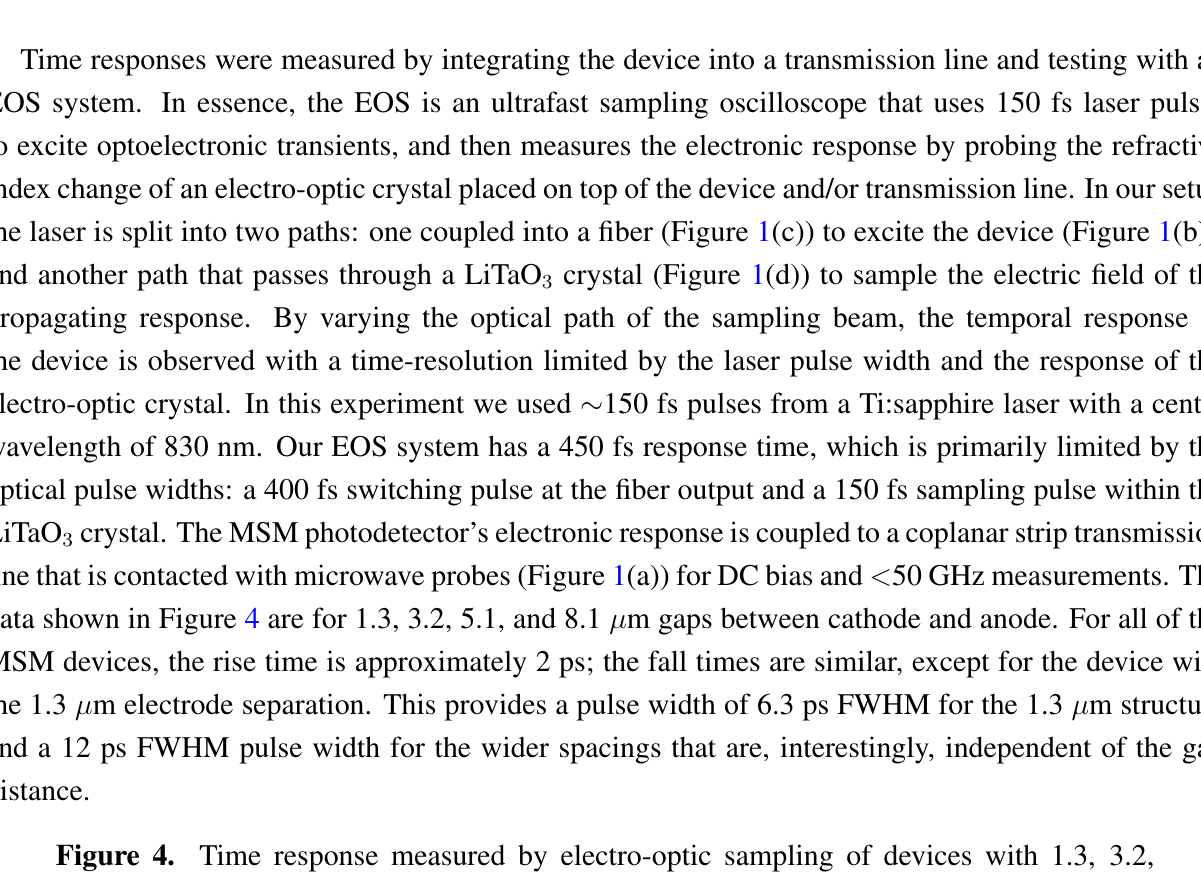
Figure 4. Time response measured by electro-optic sampling of devices with 1.3, 3.2, 5.1, and 8.1 µ m separations between cathode and anode (black, red, green and blue traces, respectively). A 6.3 ps FWHM pulse width and a 0.15 A/W responsivity is observed for